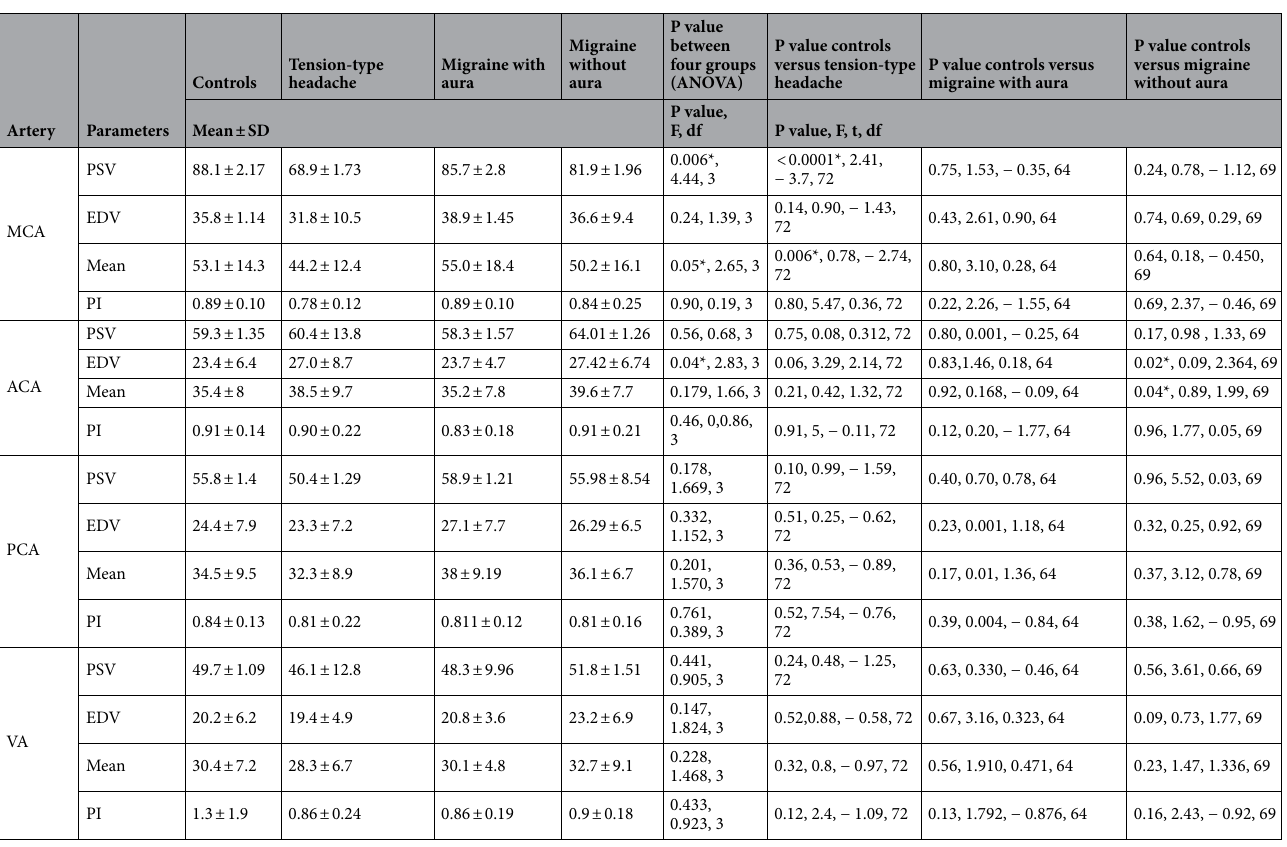
Table 3. Differences in the Resting duplex parameters of anterior and posterior cerebral circulations between control group versus each type of headache (tension headache and migraine with and without aura). MCA middle cerebral artery, ACA anterior cerebral artery, PCA posterior cerebral artery, VB vertebral artery, PSV Peak Systolic velocity, EDV End Diastolic Velocity, PI pulsatility Index, mean mean flow velocity, P value is significant < 0.05, *the significant between each group with